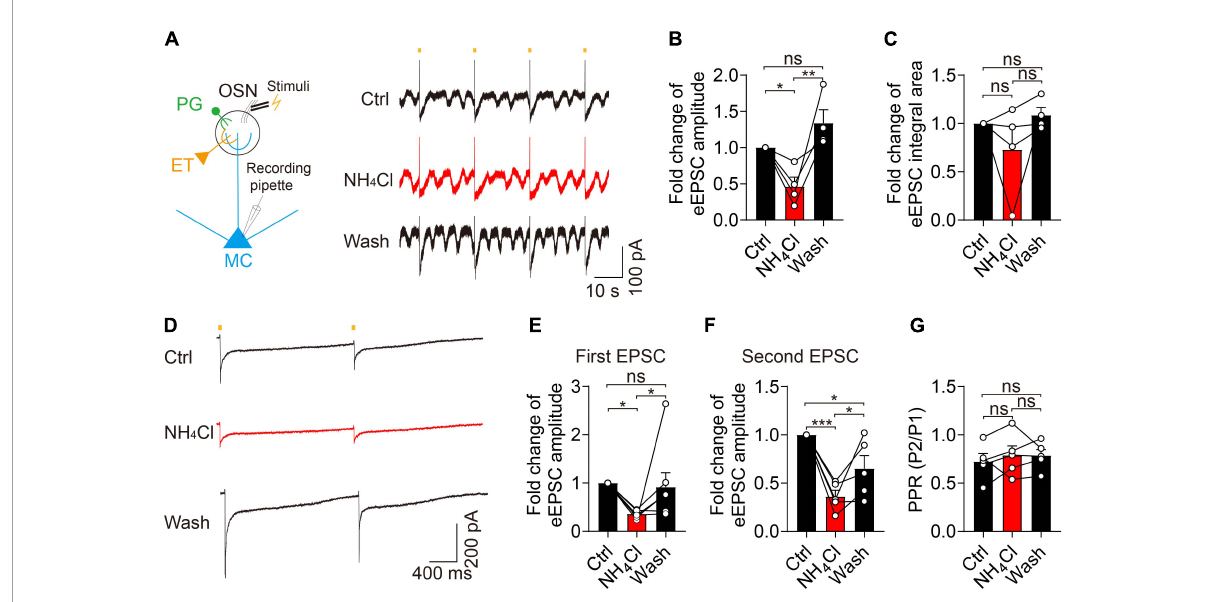
FIGURE4 Ammonium (NH 4 + ) reduced the pre-synaptic glutamate release in MCs without affecting pre-synaptic release probability. (A) Left panel showing MC recording of evoked EPSCs (eEPSCs) after stimulating OSN stubs with a bipolar electrode. Right panel showing eEPSCs from a MC by continuous single-pulse stimuli with 20 s intervals in Ctrl, NH 4 Cl, and wash solution, respectively, in the presence of Bic + Stry. (B–C) Fold change of eEPSC amplitude, and integral area in Ctrl, NH 4 Cl, and wash solution, respectively. (D) An example of eEPSCs recorded from a MC in Ctrl, NH 4 Cl, and wash solution, respectively. EPSCs were evoked by paired-pulse stimuli with an interval of 2,000 ms (determined by the slow recovery course of eEPSCs). (E–G) Pooled data showing fold changes of the first and second eEPSC amplitude and PPR (paired-pulse ratio, P2/P1) in Ctrl, NH 4 Cl, and wash solution, respectively. Error bars represent standard error; * p < 0.05, ** p < 0.01, *** p < 0.001; ns, not significant; one-way ANOVA with LSD post-hoc test.